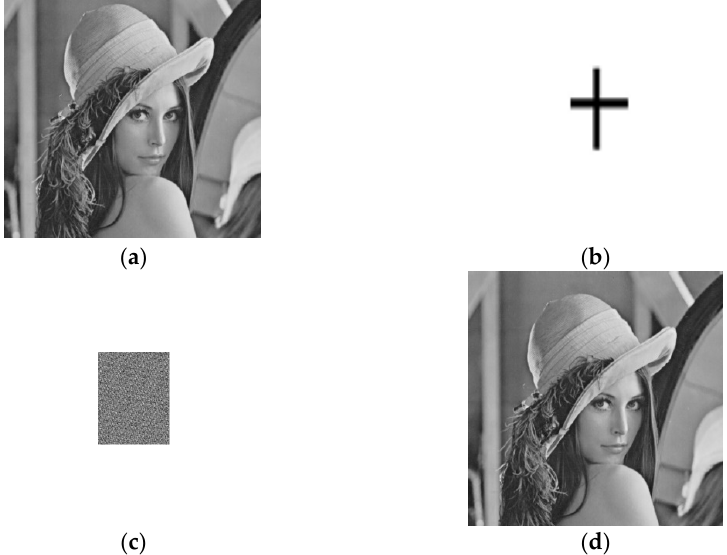
Figure 5. ( a ) Original Lena image; ( b ) watermark image; ( c ) scramble image; ( d ) watermarked Lena image.